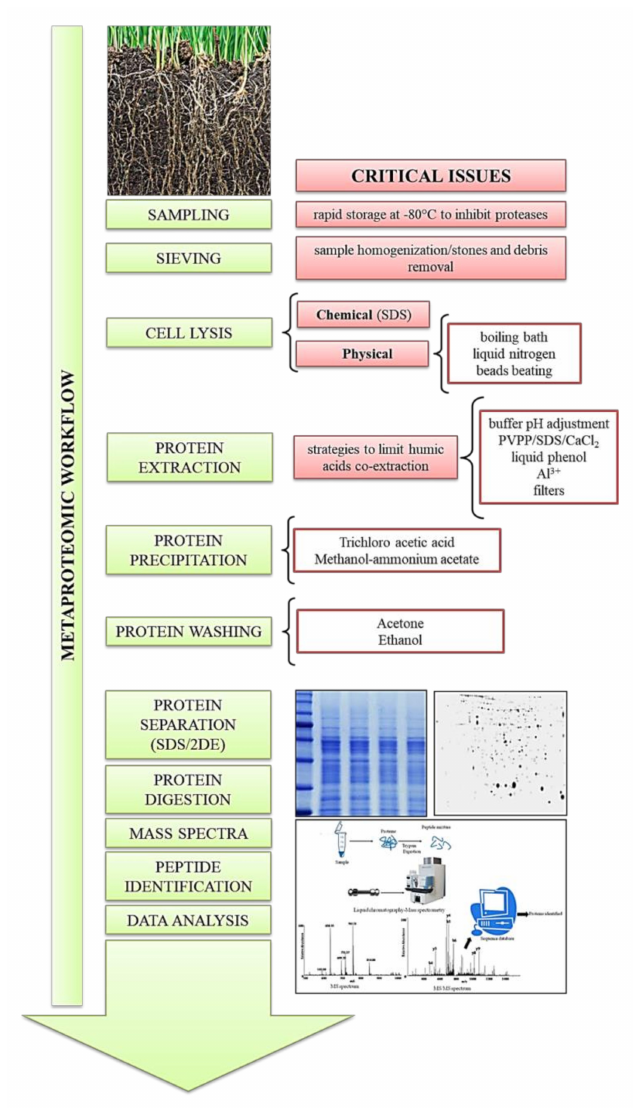
Figure 1. Metaproteomic workflow and critical